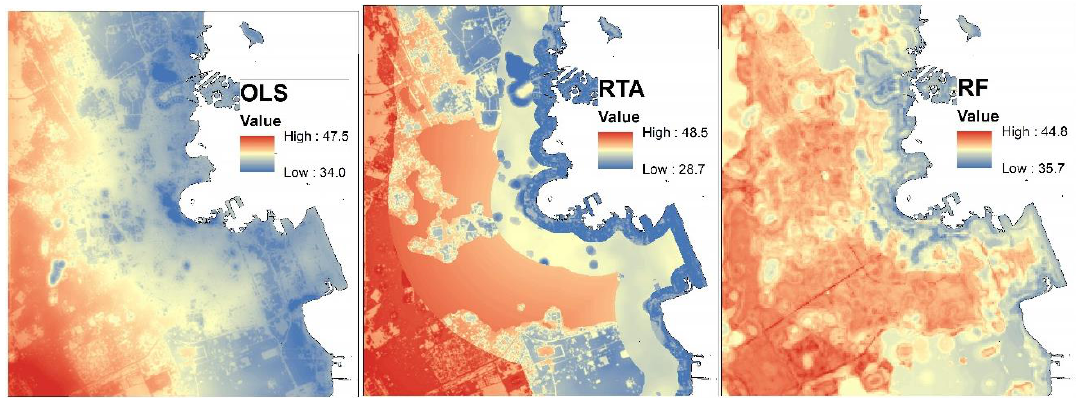
Figure 5. Predicted air temperature map (unit is in °C) using OLS ( left ); Regression Tree ( center ); and Random Forest ( right ) for 12 May 2015, 1 pm.